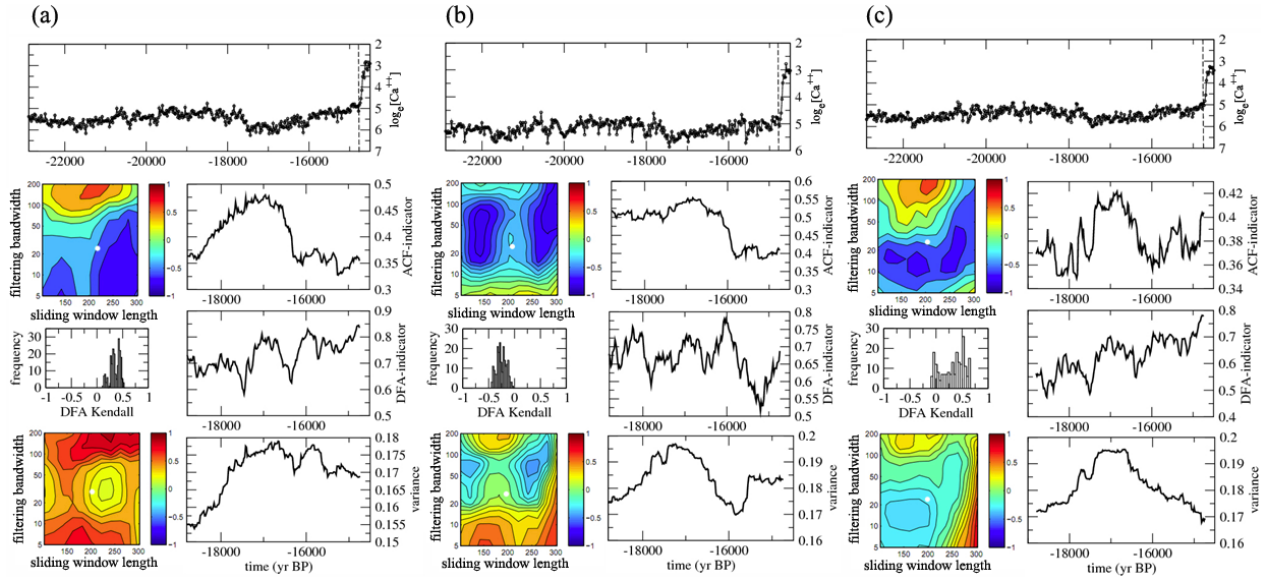
Fig. 6. Indicators of slowing down and changing variance in Greenland ice-core log e [Ca ++ ] records during the interval after DO event 2 to the Bølling warming (DO event 1): (a) GRIP (b) GISP2 (c) NGRIP. Here the analysis spans 22.88–14.74ka ( n =408), stopping at the vertical dashed line before the Bølling warming. Otherwise panel descriptions are as in Fig.